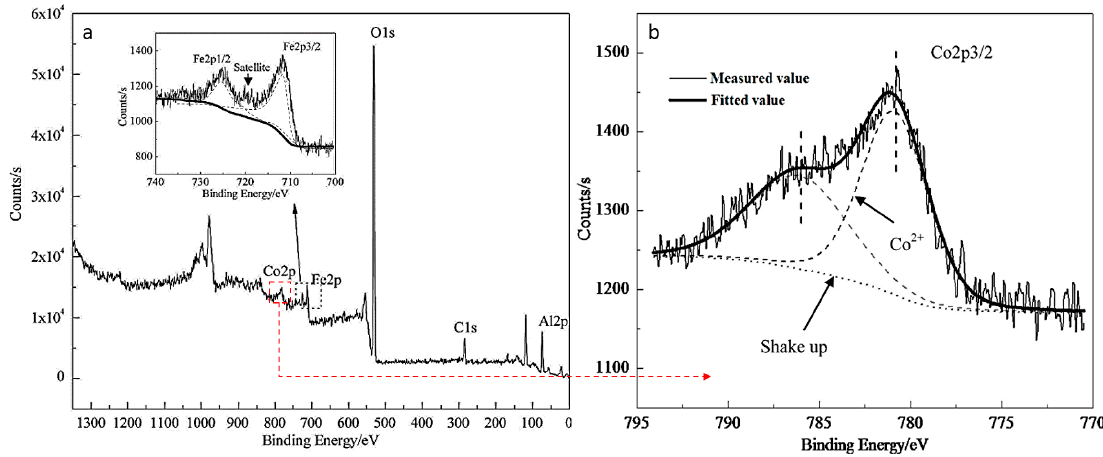
Figure 4. ( a ) XPS spectrum of Fe-Co/ γ -Al 2 O 3 (inset: high resolution XPS of Fe 3+ ); ( b ) High resolution XPS of Co 2+ . Figure 4 (XPS spectrum of Fe-Co/ γ -Al 2 O 3 ): the full spectrum scanning pattern of Fe-Co/ γ -Al 2 O 3